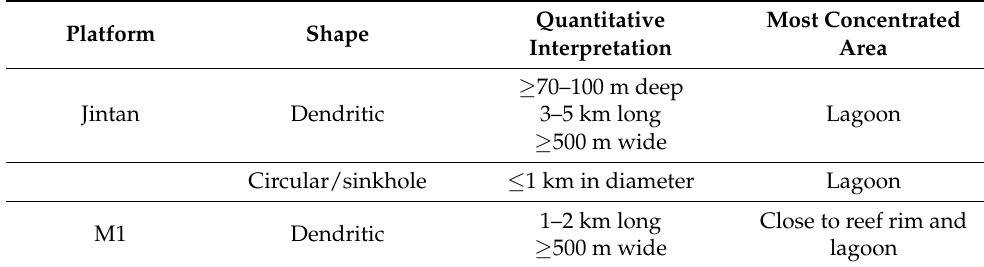
Figure 16. Evolution of the karst features on selected K1, K2, and K3 horizons show that the karst features are well- developed and more prominent on the K2 horizon, highlighting that the heavily karstified intervals falls in between SU4 and SU5 as interpreted by [10]. Table 3. Quantitative interpretation of the karst features observed on Jintan and M1